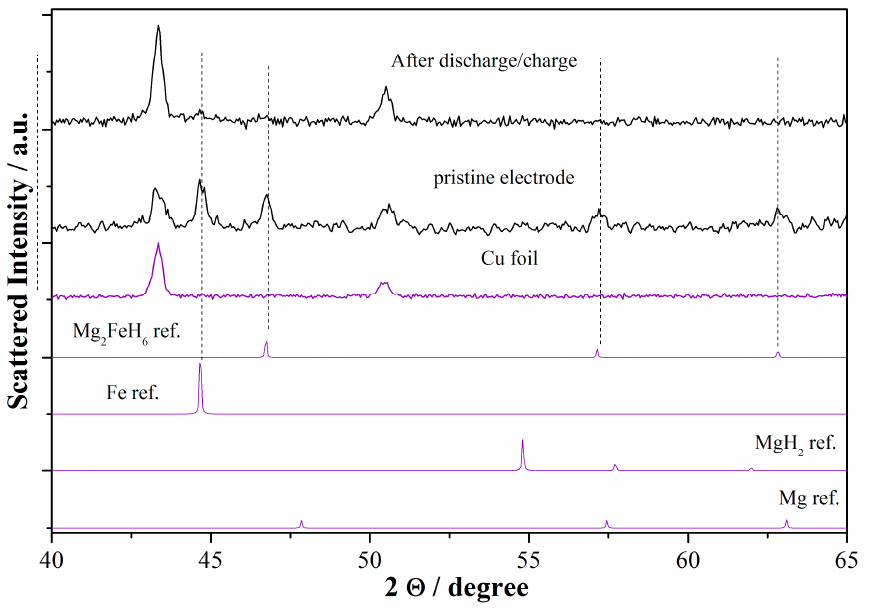
Figure 5. XRD patterns of the RBM electrode recorded after 1 galvanostatic cycle in lithium cells compared to the pristine material and references.